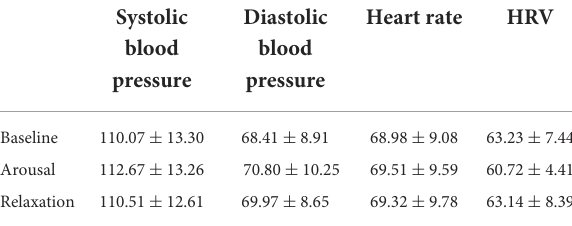
TABLE 1 Outcome of measurements (Mean ± SD) at the three time